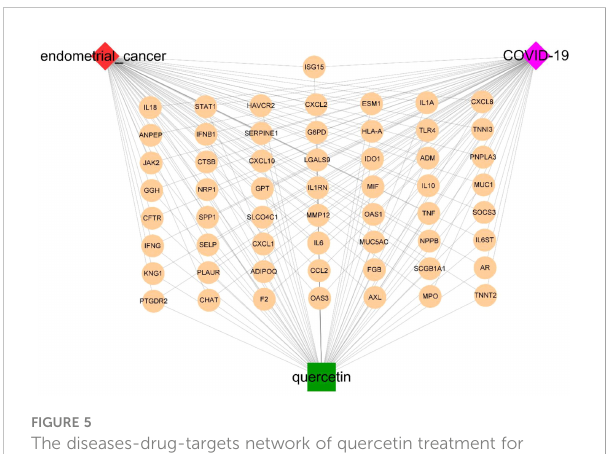
FIGURE 5 The diseases-drug-targets network of quercetin treatment for UCEC/COVID-19 patients.